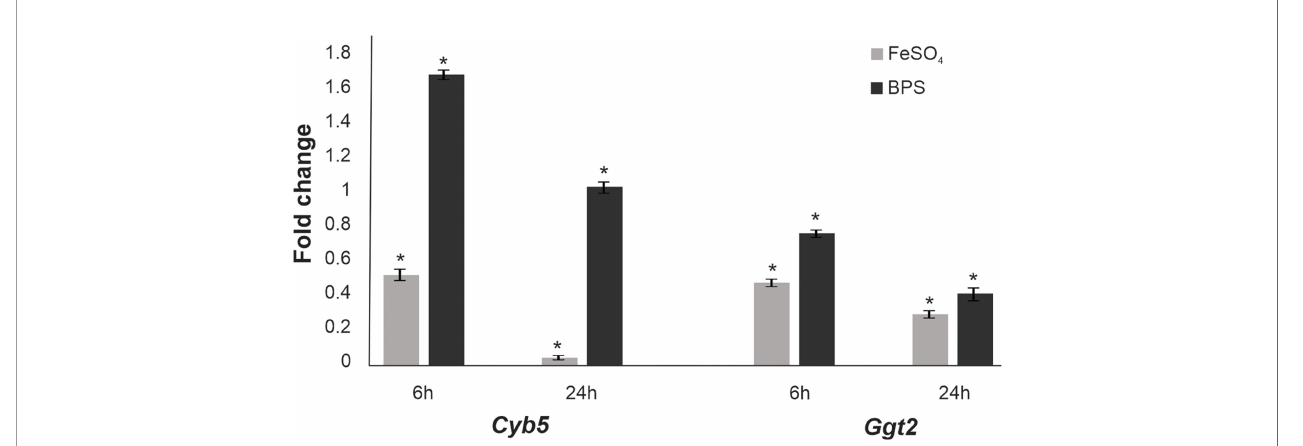
FIGURE 2 | Expression quanti fi cation of selected genes in Paracoccidioides brasiliensis by RT-qPCR. Quantitative RT-PCR data showing the transcript levels of cytochrome b5 ( Cyb5 ) and gamma-glutamyl transpeptidase ( Ggt2 ) in the presence and absence of iron at 6 and 24 h. The data were normalized using the gene encoding the 60S ribosomal protein L34 as the endogenous control and are presented as relative expression to the control. Data are expressed as the mean ± standard deviation of the triplicates of independent experiments. Student ’ s t-test was used for statistical comparisons. Error bars represent the standard deviation of three biological replicates, and * represents p ≤ 0.05.